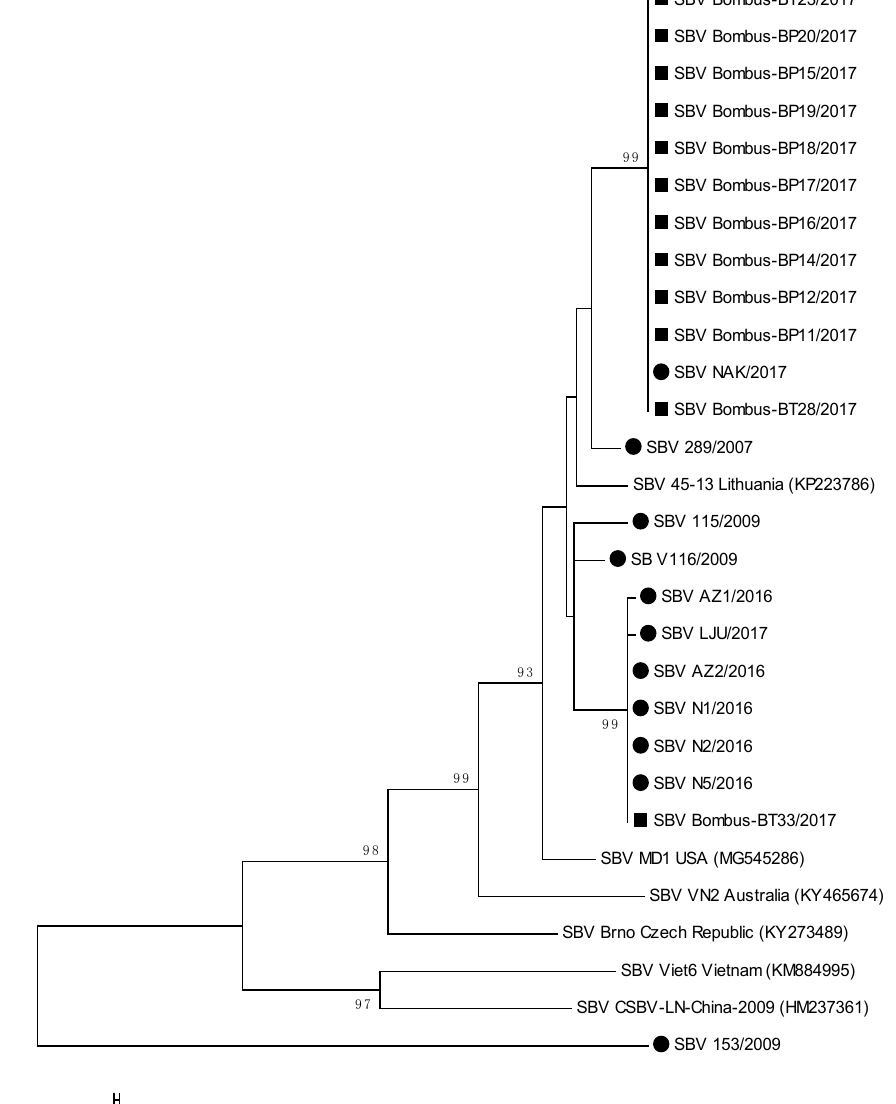
Figure 4. Phylogenetic comparison of 11 SBV positive samples detected in honeybees ( ● ) and 14 SBV positive samples from bumblebees ( ■ ) in Slovenia. The comparison was based on the 783-nucleotide long sequences of the viral genome region coding for polyprotein (nt genome position between 4992 and 5774, numbering according to strain MD1, MG545286), together with the six genetically closest genes from the GenBank (with accession numbers).